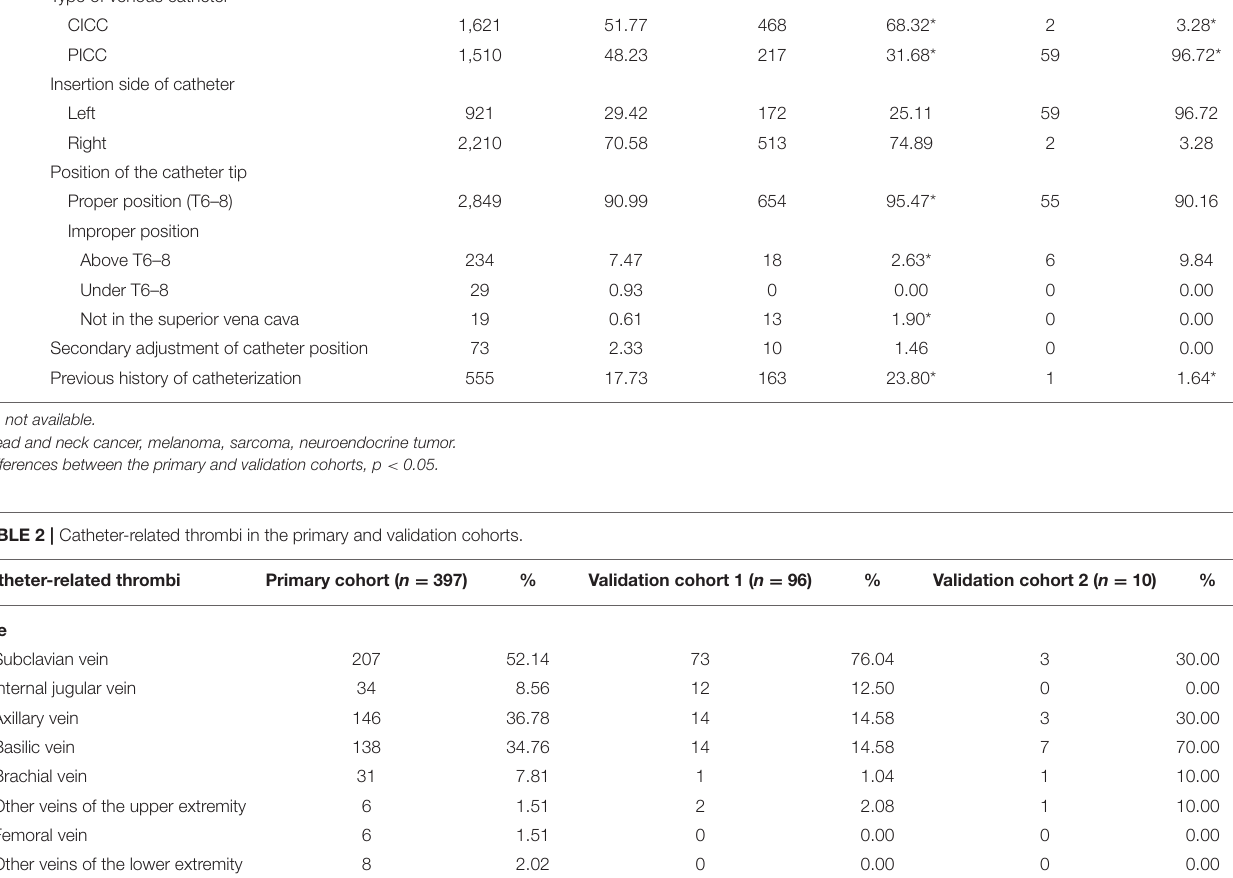
Supplementary Table 2 . The multivariate analysis